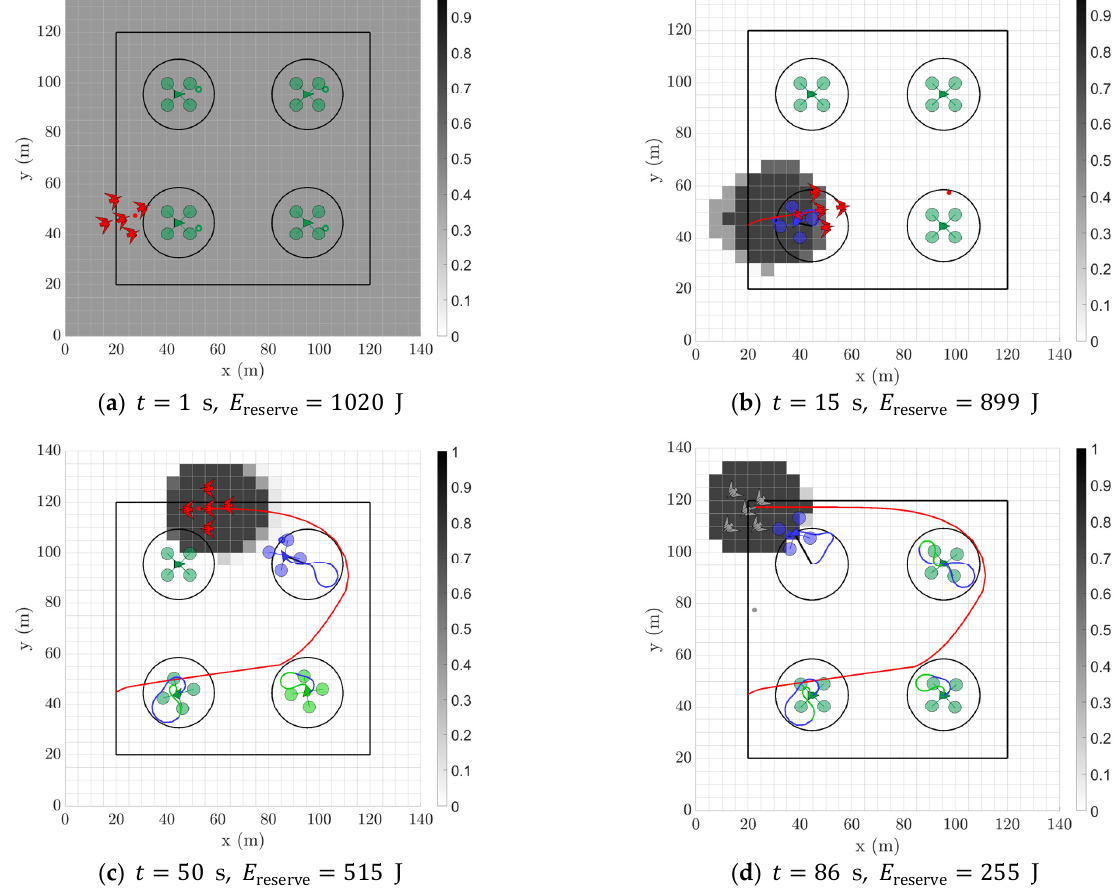
Figure 10. Snapshots of a sample single target flock simulation with the following configuration: n = 4 agents, R T = 14 m, v max = 12 m/s. Simulation begins in ( a ) with each target in the target flock at the full energy reserve of 1020 J, all agents undeployed in their Home state, and each cell in the probability map initialised with the same value. As the simulation progresses from ( b )–( c ), the target flock seeks to find grid cells of maximum interest indicated by the red dot but is repelled by nearby deployed agents, shown in their Chase state, while agents that were deployed but no longer in range are shown in their Return state. Simulation is completed in ( d ) with the target centre (greyed out) no longer in the protected area by 𝑡 = 86 s and the original energy reserve quartered.